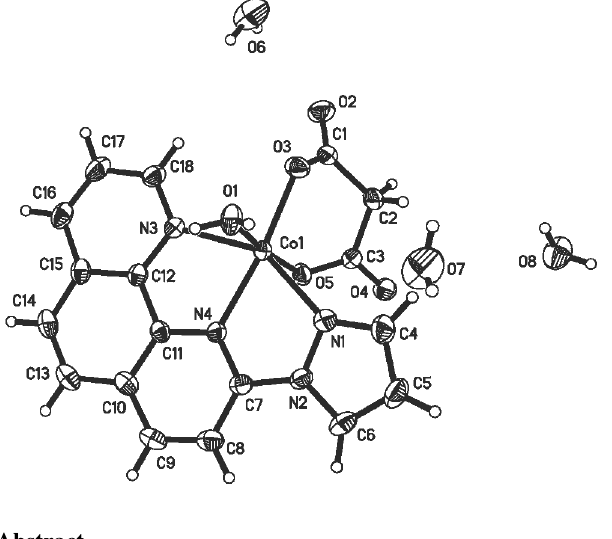
Table 2. Atomic coordinates and displacement parameters (in Å 2 )